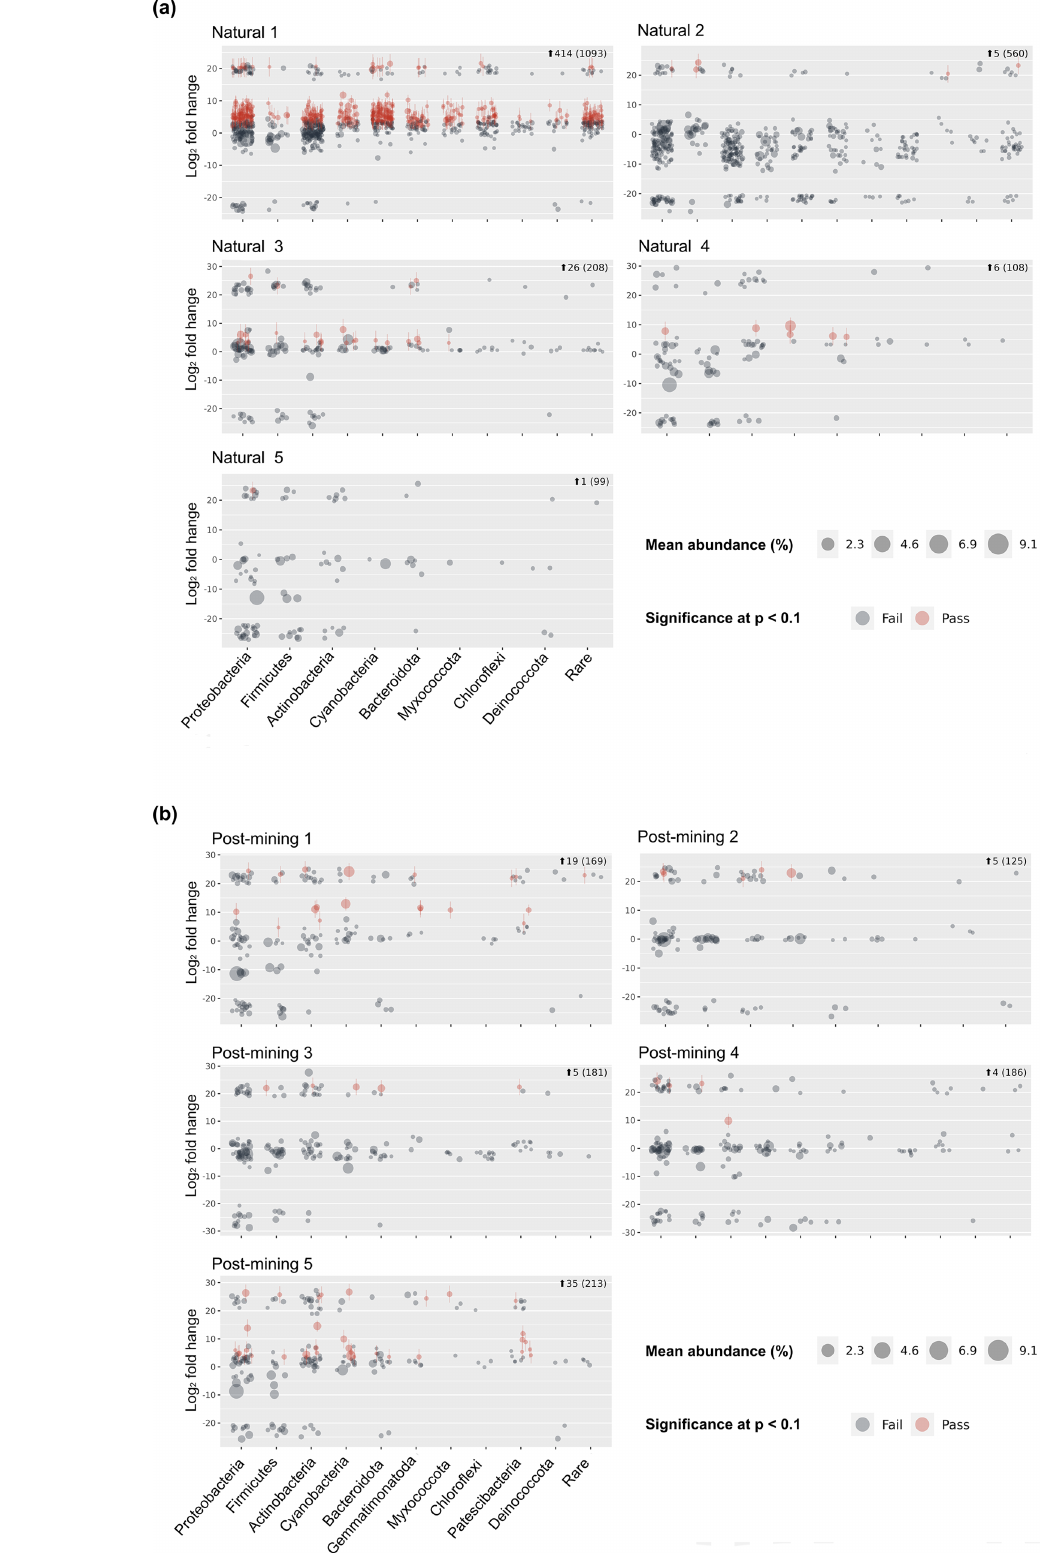
Figure 4. Community composition of proliferated bacteria in natural (a) and post-mining (b) biocrusts. Each graph represents a different sample. Red dots indicate labeled ASVs, and gray dots indicate unlabeled ASVs, based on Deseq2 modeling.